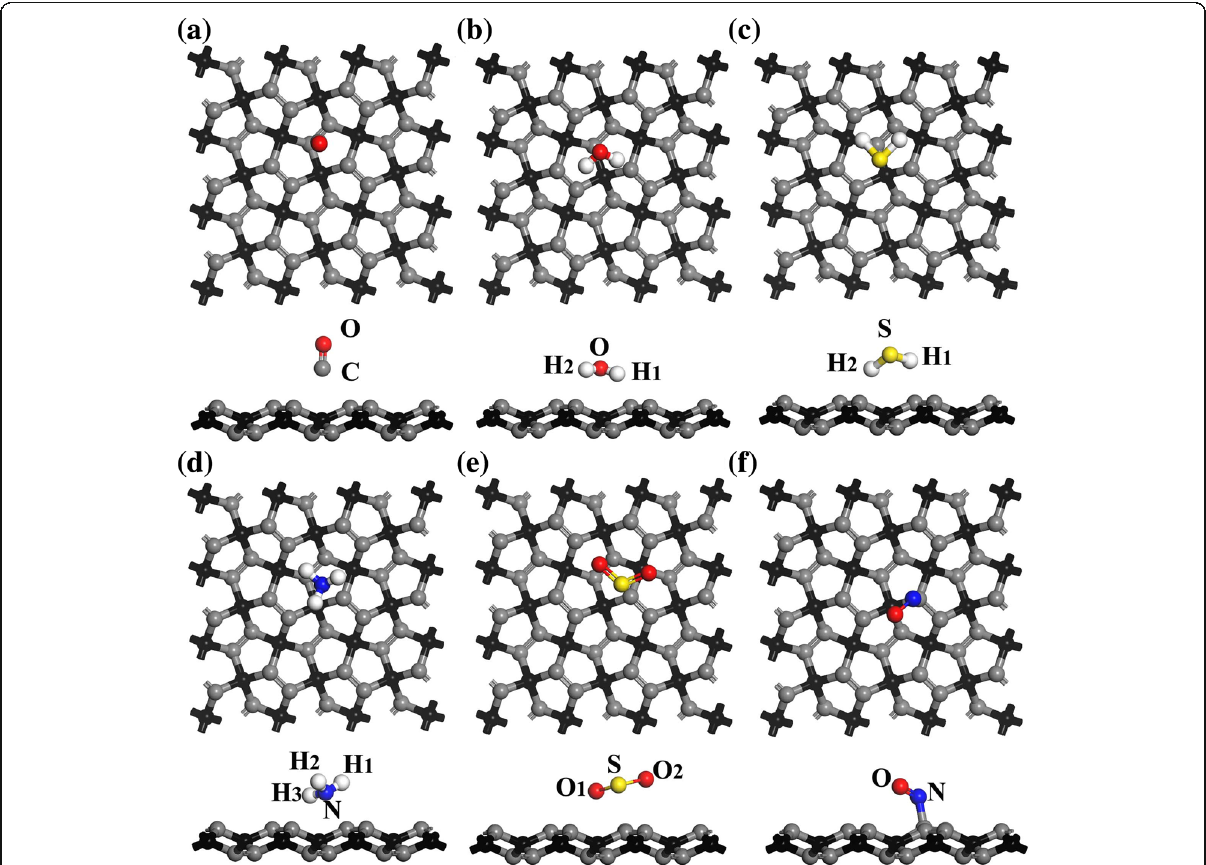
Fig. 2 Top and side views of the most favorable adsorption configurations for a CO, b H 2 O, c H 2 S, d NH 3 , e SO 2 , and f NO on PG. The gray, red, white, yellow, and blue spheres represent C, O, H, S, and N atoms,